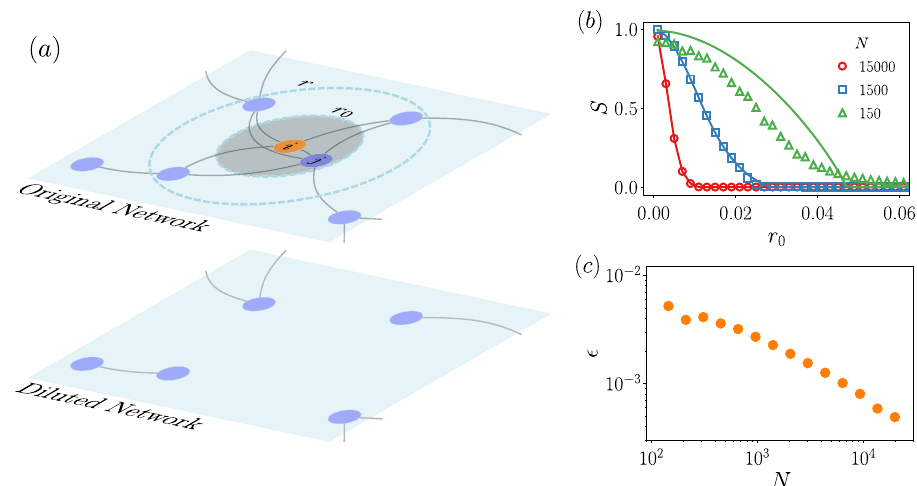
Fig. 4 Feature-based percolation in random geometric graphs. In ( a ), a sketch showing how the removal of nodes proposed in the main text works: if a node i (central orange marker in this case) has its closest neighbor at a distance smaller than r 0 (shaded area), then i is removed. This removal condition is checked synchronously for all nodes at once, hence node j in the sketch is also removed because, since the network is undirected, i is a neighbor at a distance smaller than r 0 . In ( b ), the size of the giant connected component is a function of r 0 . The interaction radius is set to r = 0.1, above which links cannot be drawn, and kept the same for all simulations. Different system size N are explored, indicated in the legend. Solid lines correspond to the theoretical approximation from Eq. (17) and markers are results from simulations. In ( c ), a discrepancy between theory and simulations, Eq. (18), as a function of the system size. All simulation points are averaged over 100 independent